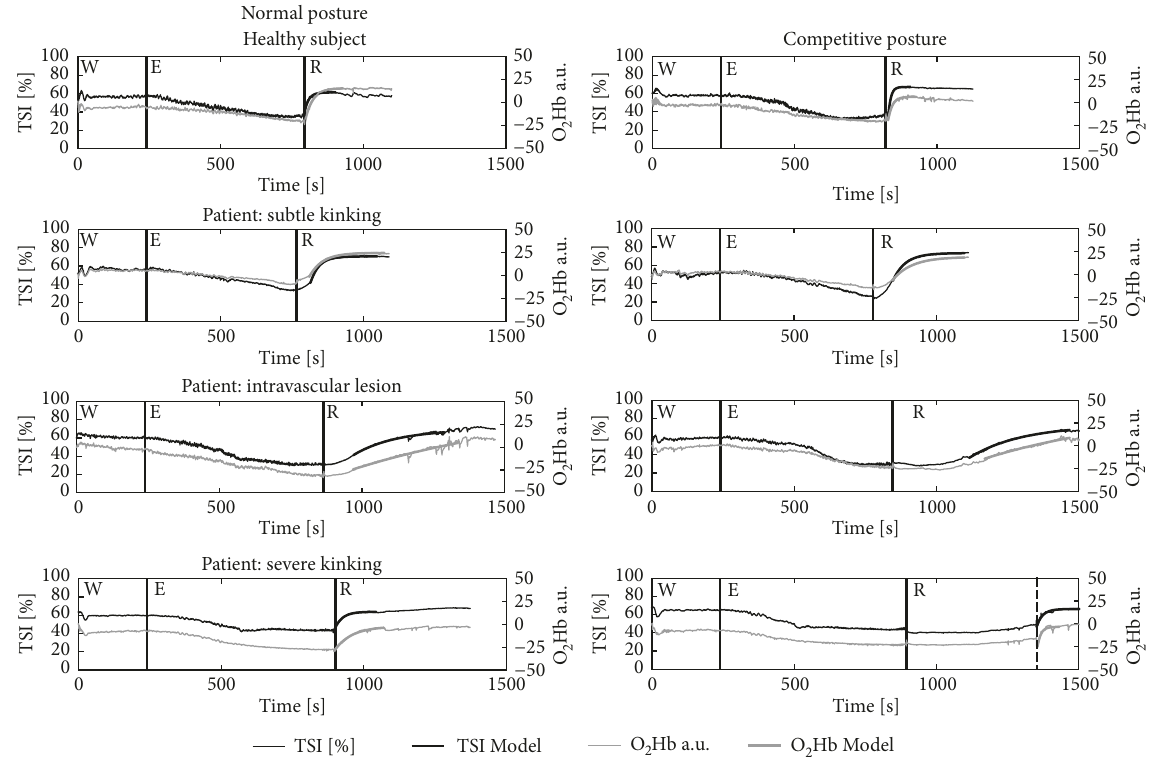
Figure 4: TSI and O 2 Hb patterns during warm-up (W), RAMP exercise protocol (E), and recovery (R); solid vertical lines denote phase transitions, the dashed line in CP with severe kinking represents the sudden change from CP to NP.